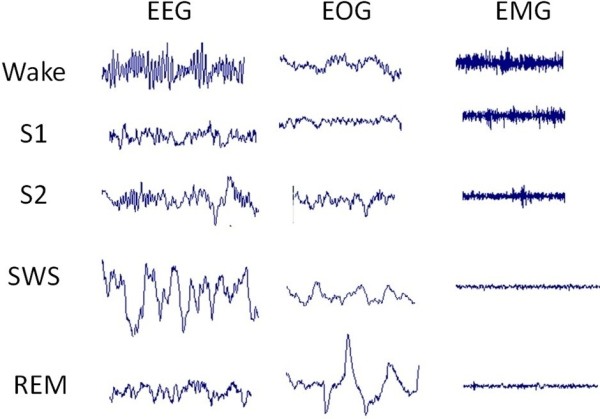
Typical polygraphic recordings during the wake (WK), stage 1 (S1), stage 2 (S2) light sleep, slow-wave sleep (SWS) associated with deep sleep, and rapid-eye movement (REM) states. Legend: Each raw shows the electroencephalography (EEG), electrooculography (EOG) and chin electromyography (EMG) data during the corresponding sleep stage.